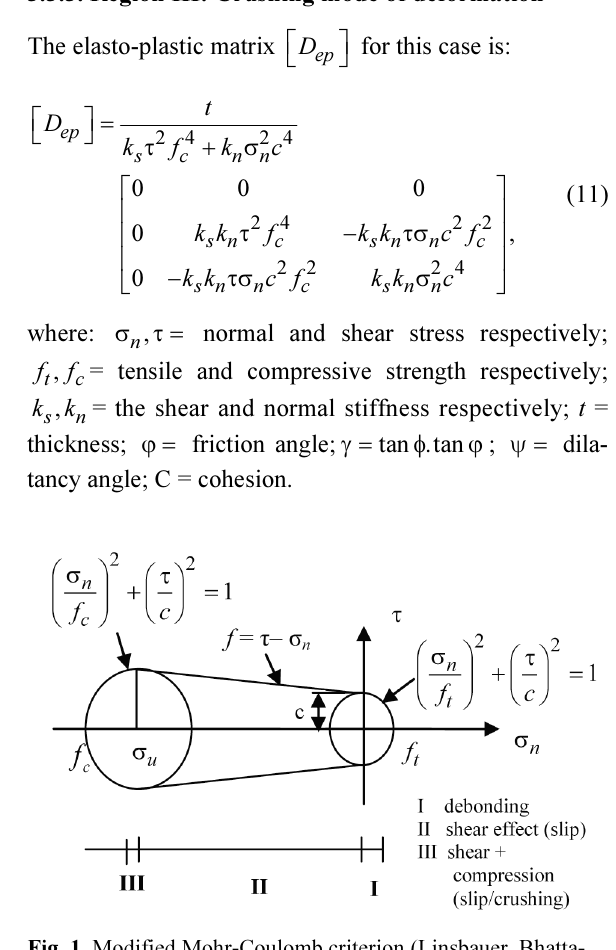
Fig. 1. Modified Mohr-Coulomb criterion (Linsbauer,